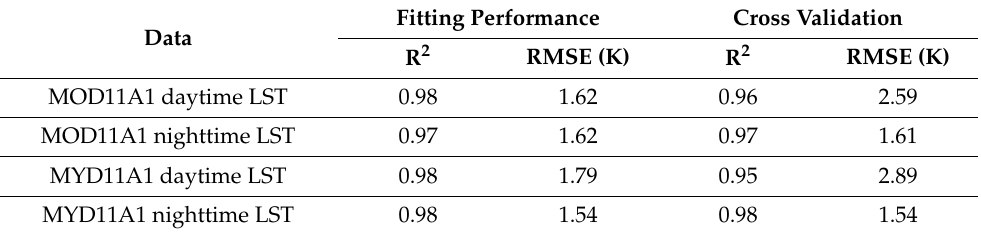
Table 3. Performance of the XGBoost-based linking models on DOY 167 of 2018. Fitting Performance Cross Data